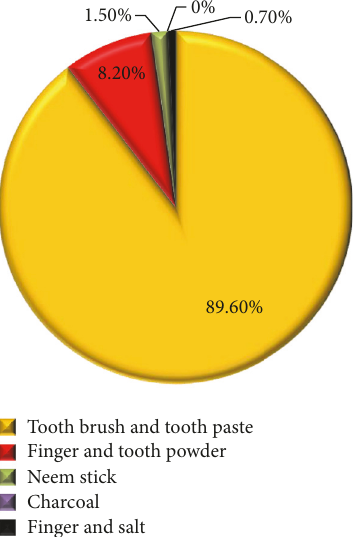
Figure 2: Mode of cleaning the teeth among the study subjects.